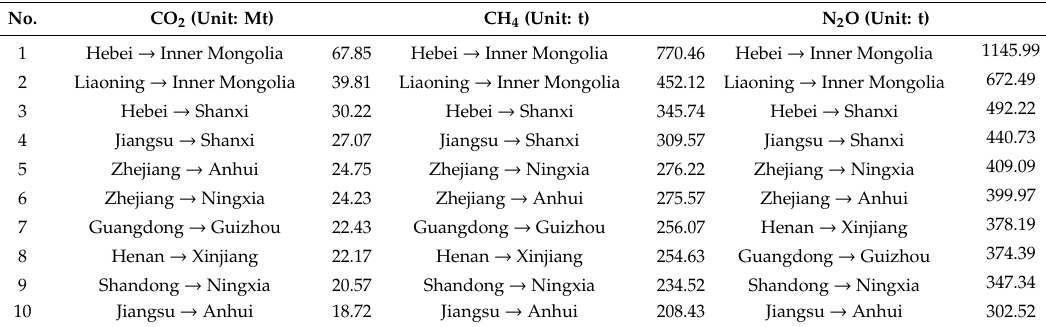
Table 3. Major transfer pathways of CO 2 , CH 4 and N 2